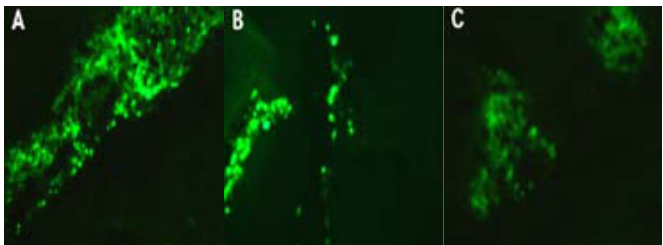
FIGURE 3 - Migration of implanted mESCs after focal ischemia. GFP- positive cells were transplanted into the lateral ventricle (LV) on the side of the ischemic after MCAO. Transplanted cells were found in the ischemic region ( A,B,C